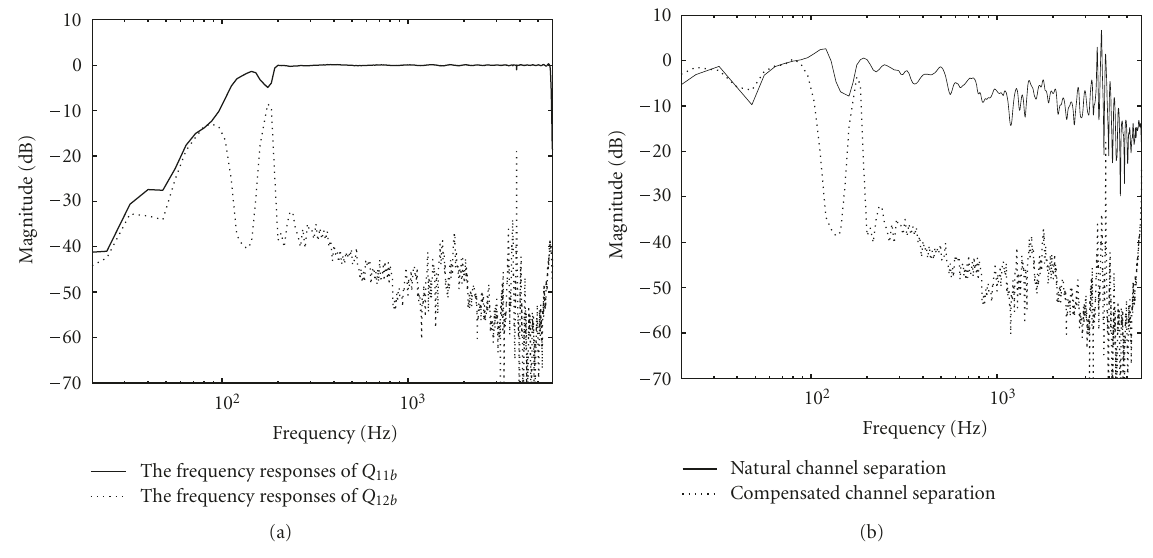
Figure 7: (a) The frequency responses of Q 11 b and Q 12 b . (b) Natural channel separation and compensated channel separation.